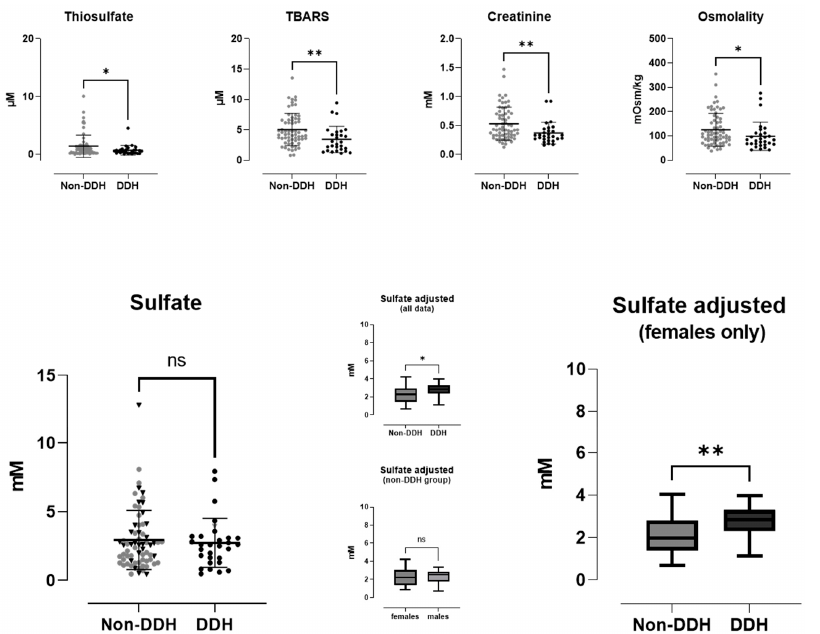
Figure 2. Upper row: Urinary concentrations of thiosulphate, thiobarbituric acid reactive substances (TBARS), creatinine, and osmolality in infants with DDH compared to age-matched controls (non- DDH). Lower Row: Left : Distribution of unadjusted urinary sulphate concentrations in non-DDH and DDH infants (triangles—boys; circles—girls). Middle : After adjustment for osmolality, urinary sulphate concentrations differed between DDH and non-DDH babies whereas in the non-DDH group, sulphate concentrations showed no difference between males and females. Right: Differences between groups are even more marked if only girls were compared. Scatter plots show non-normalised data with significant differences in analyte concentrations between the non-DDH and DDH group (distribution of other analytes with non-significant (ns) differences between groups not shown) whereas the box and whisker plot for sulphate depicts osmolality-adjusted concentrations. * = p < 0.05 . ** = p < 0.005